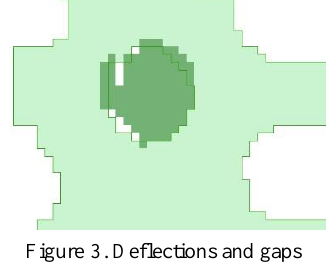
Figure 3. Deflections and gaps